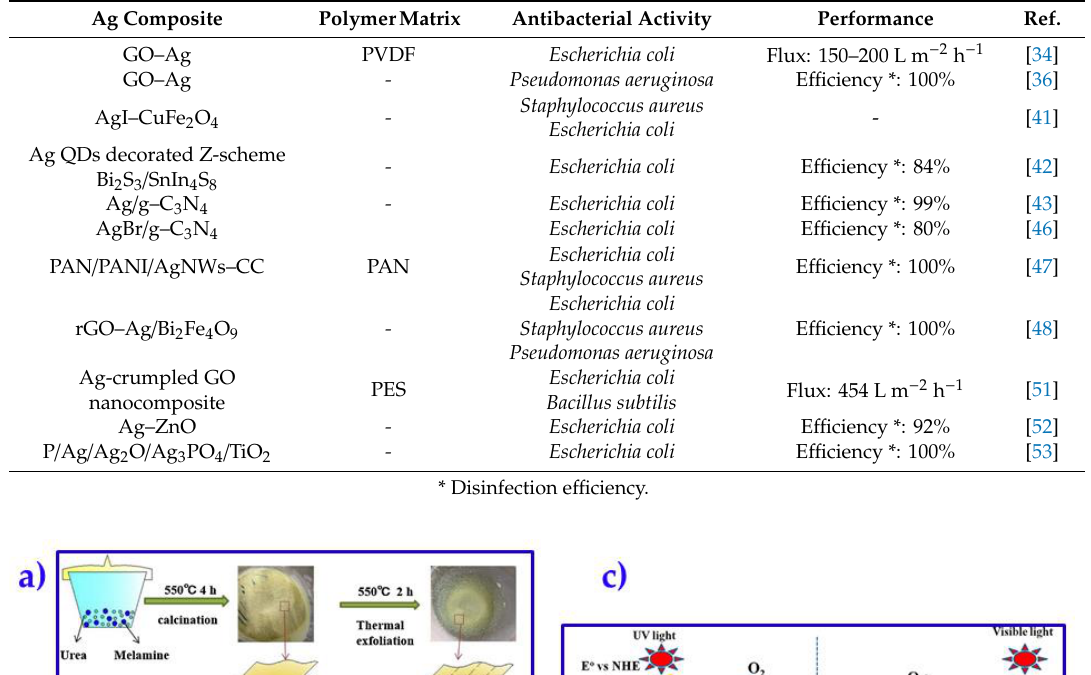
Table 1. Recent studies on combining Ag nanoparticles with other materials.